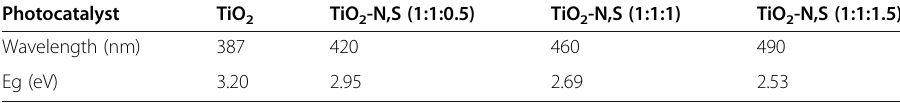
Table 1 The effect of co-doping on the decreasing Eg